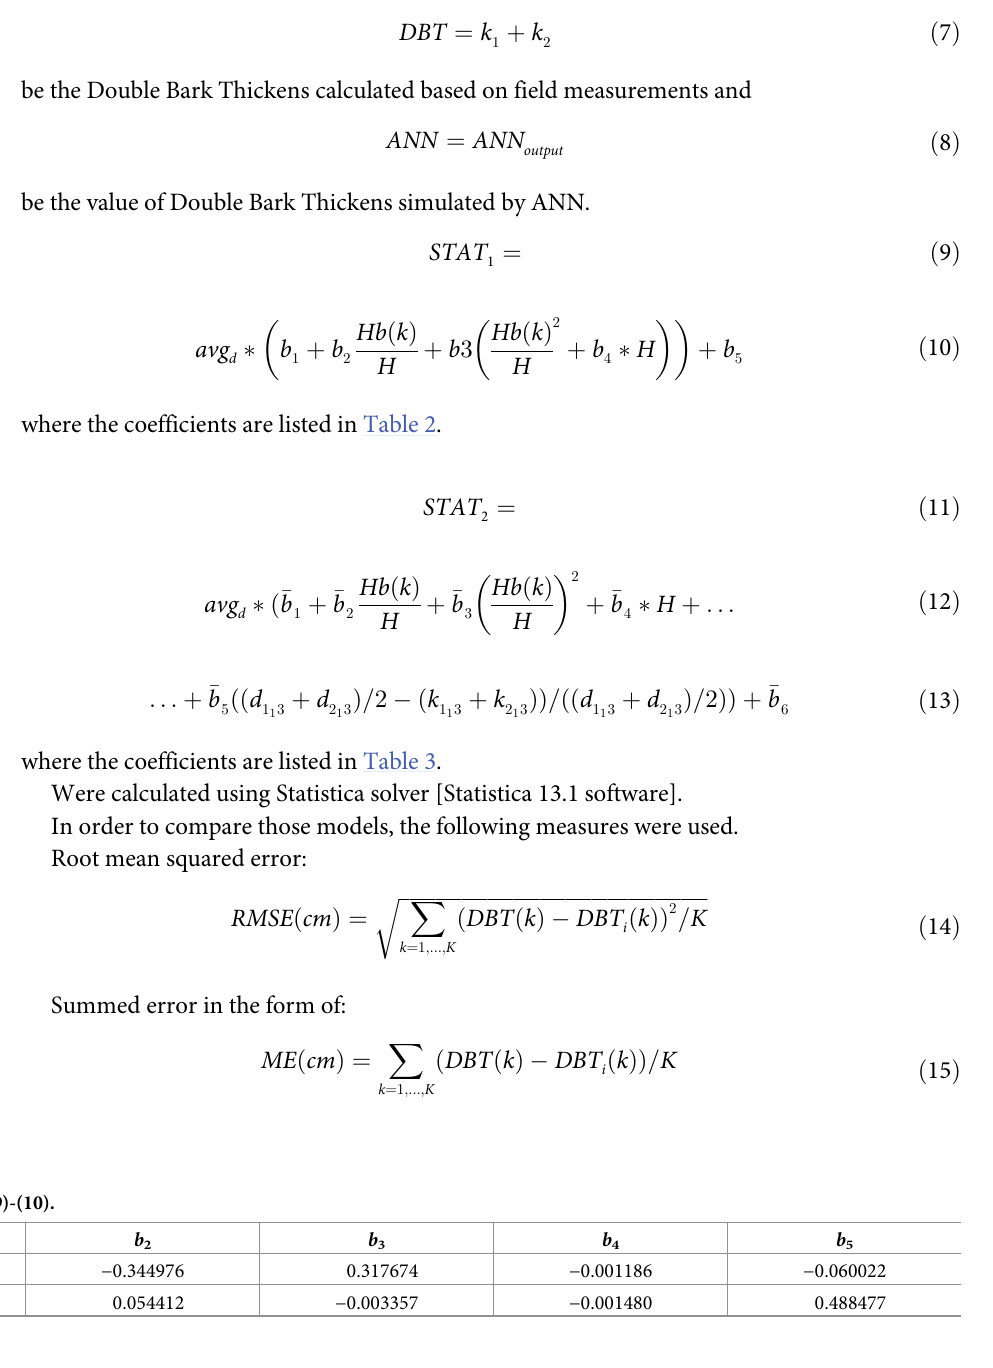
Table 3. The coefficients of statistical models (11)-(12).